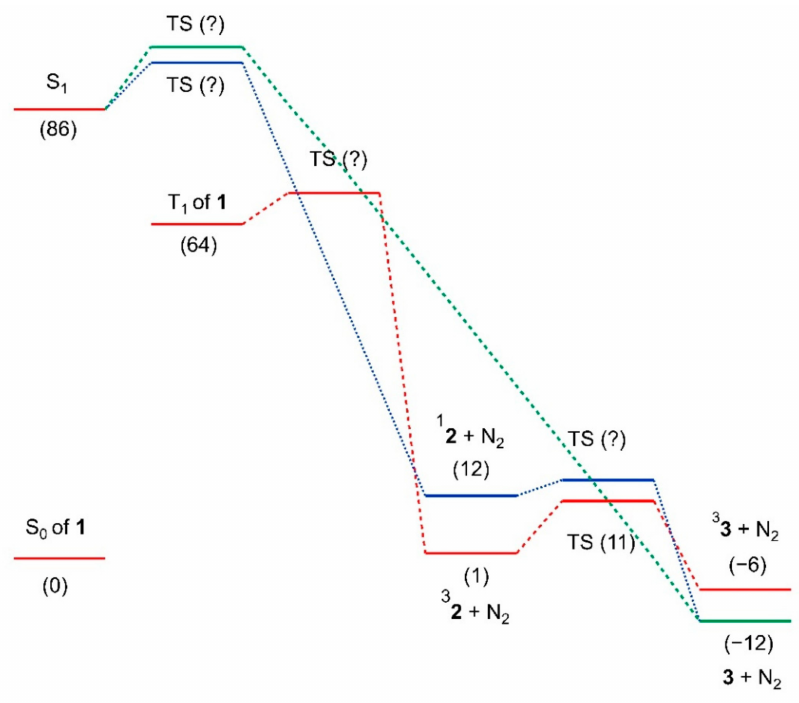
Figure 4. Calculated stationary points on the singlet and triplet energy surfaces of azidoisoxazole 1 using the B3LYP / 6-31 + G(d) level of theory. The numbers in parentheses are the energies in kcal /